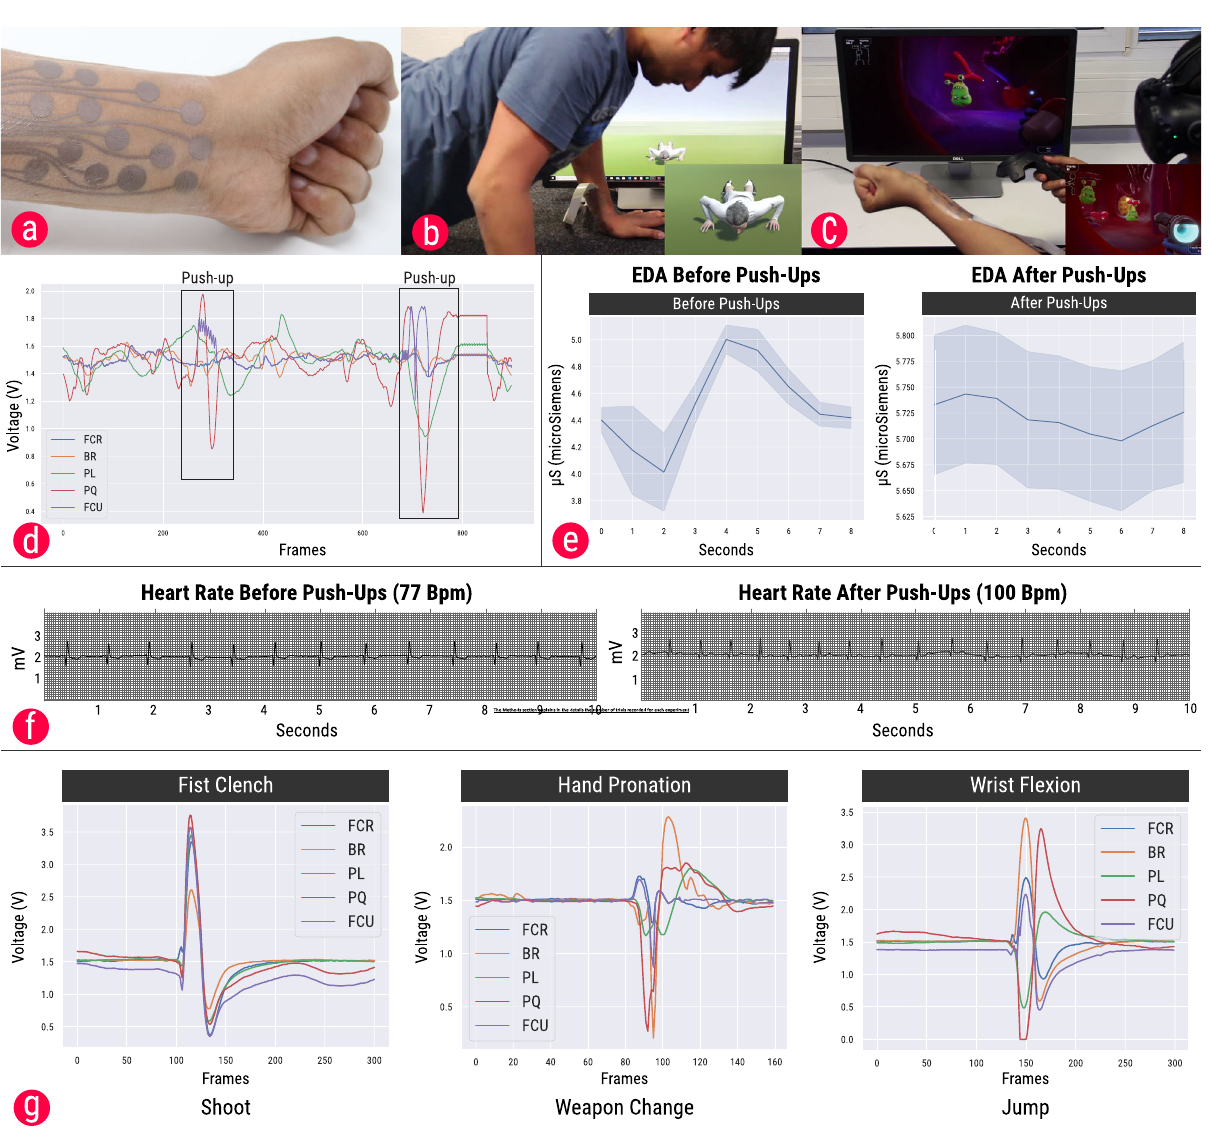
Fig. 4 Example applications. a Ultra-thin temporary tattoo with compact sensor layout generated by the optimizer and fabricated with an off-the-shelf desktop inkjet printer. b Augmented reality exercising application: a virtual character performs push-up motion when the user performs a push-up. c A virtual reality game in which EMG-sensed gestures are used for controlling the virtual character in a fi rst-person shooter game. d Raw signals of the EMG signals when performing a push-up exercise. e Increase in the skin conductivity levels before and after the push-ups. The shaded region represents the standard deviation. f Difference in the heart rate before and after performing the push-ups. g Raw EMG signals of the fi ve muscles for each of the gestures used in the virtual reality